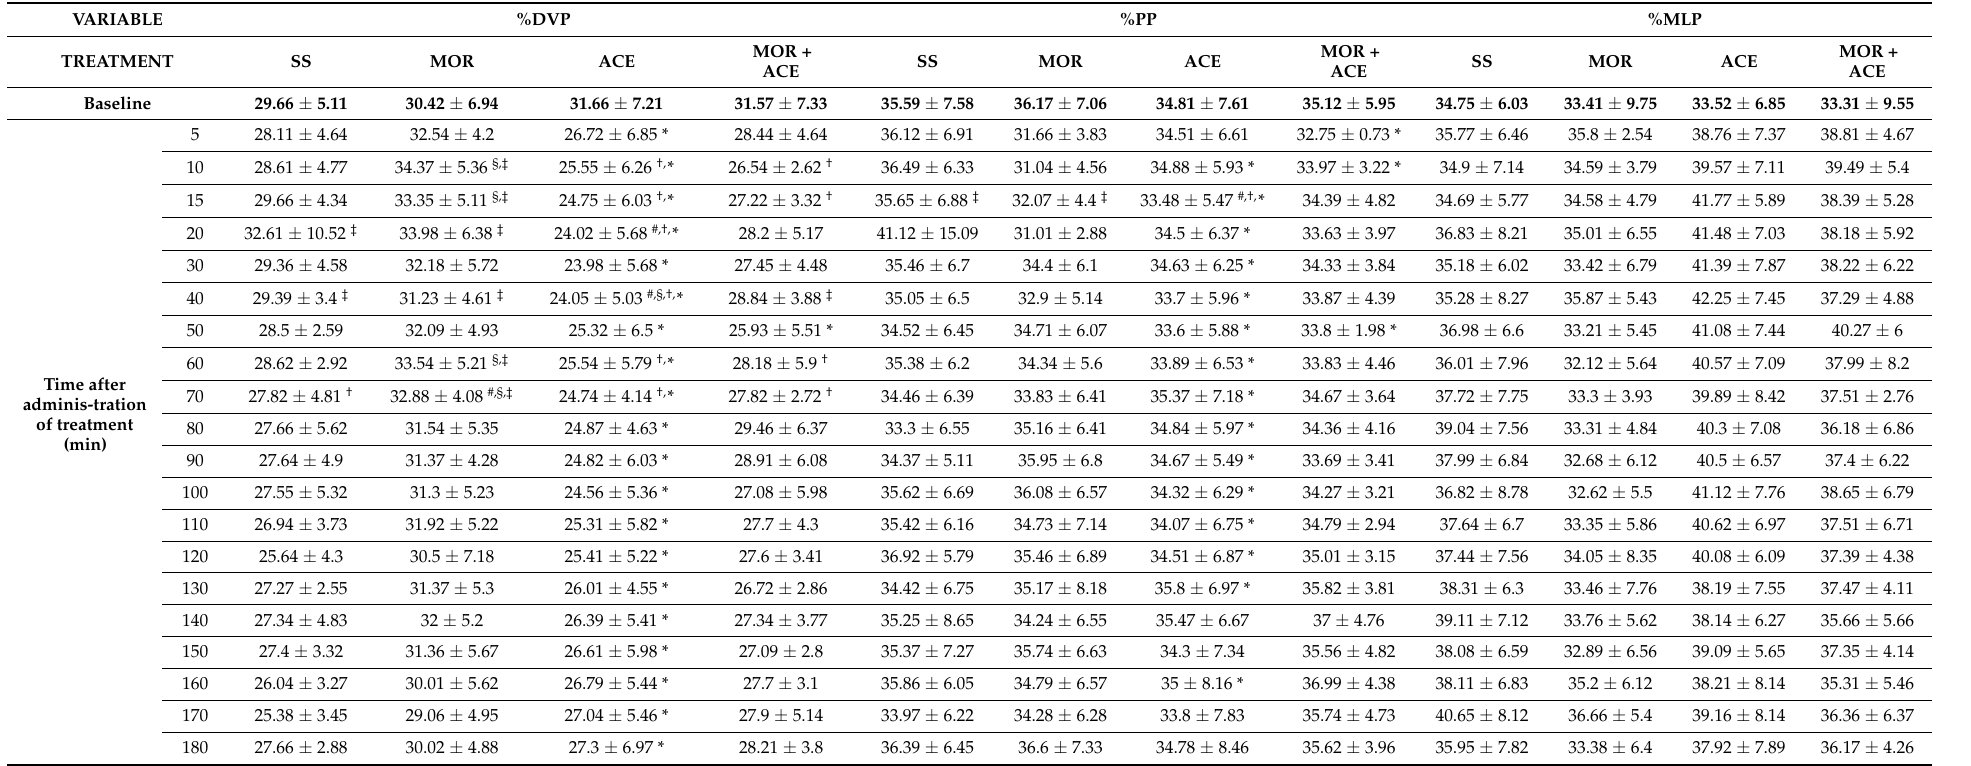
Table 5. Values at walk of energetic variables at − 10, 5, 10, 15, 20, and then every 10 min (total period of 3 h) after IV injection (at 0 min) of 10 mL of sodium